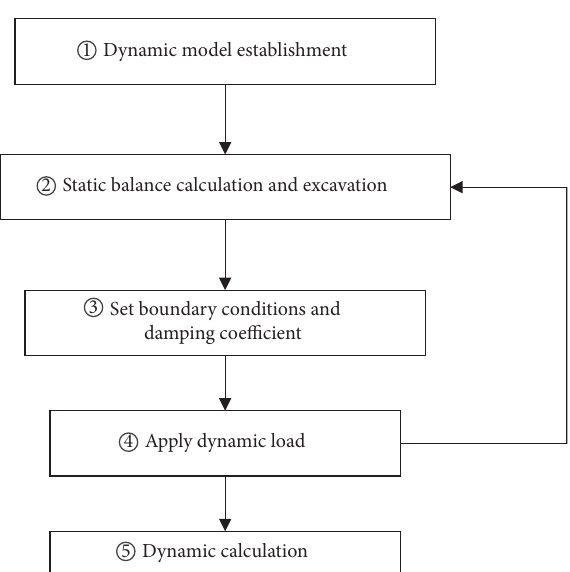
Figure 5: Schematic diagram of dynamic wave disturbance.